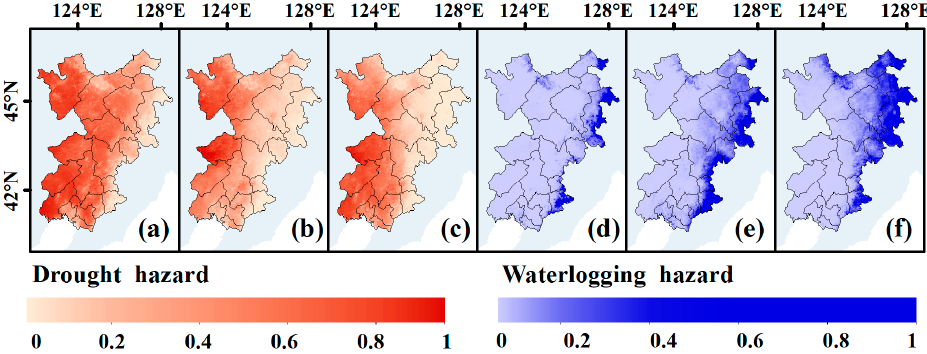
Figure 15. Drought and waterlogging hazards on maize at the different growth stages: ( a – c ) the spatial distributions of the hazards in the early, middle and late growth stages of maize, respectively; and ( d – f ) the spatial distributions of the hazards in the early, middle and late growth stages of maize, respectively.